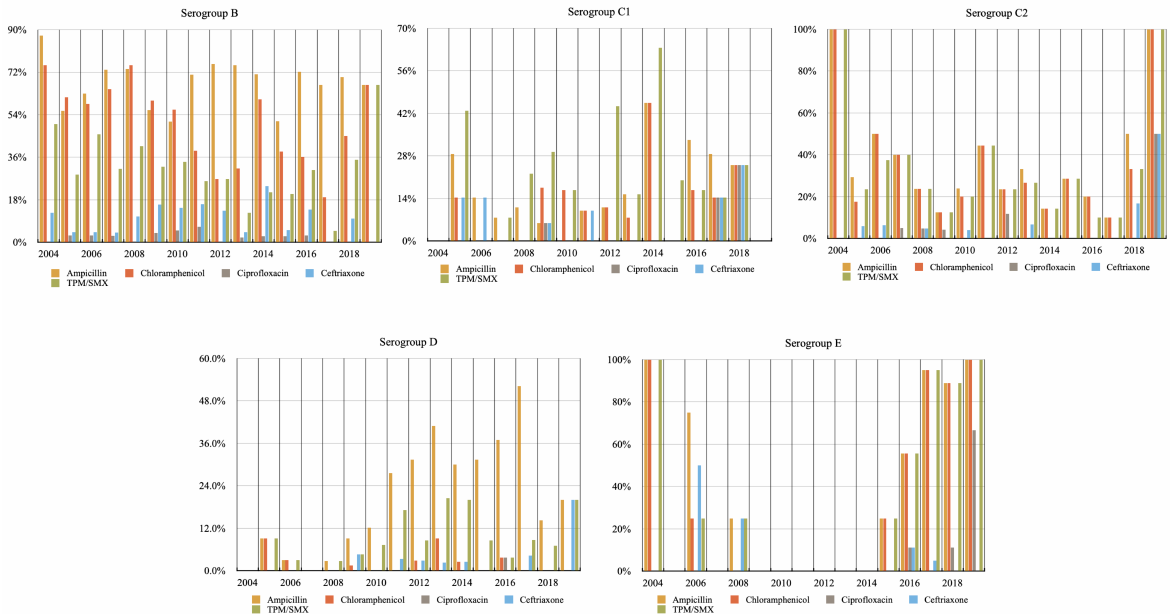
Figure 2. The prevalence of the non-susceptible isolates in different serogroups to antimicrobials in each